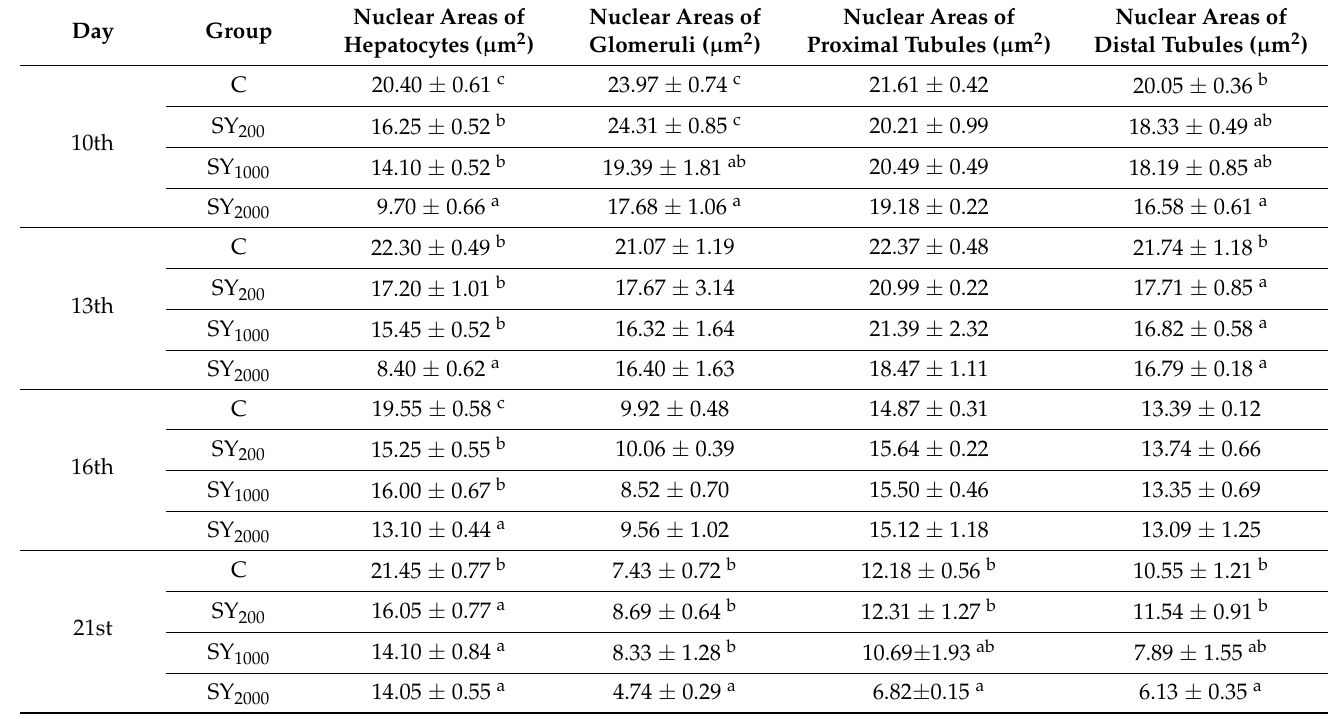
Table 2. Nuclear areas of structures in liver and kidney tissues (Mean ±